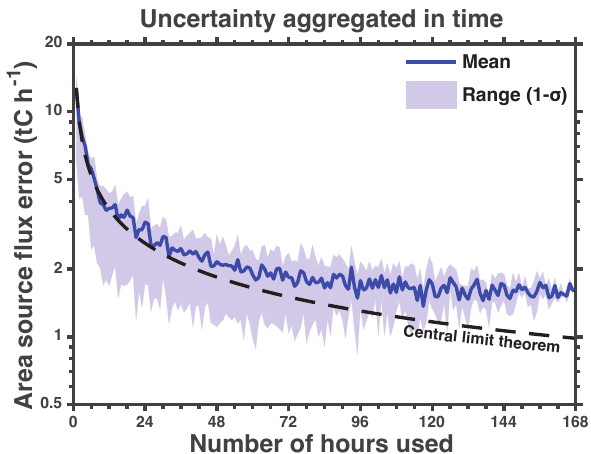
Figure 5. Uncertainty aggregated in time for the best-case inver- sion (see Fig. 3). The CO 2 flux estimate in this study has an hourly temporal resolution. The uncertainty in the emissions estimate de- clines as the estimate is averaged to longer temporal scales. Solid blue line is the mean uncertainty, shading is the 1 σ range, and the dashed black line is the uncertainty predicted by the central limit theorem. Note the log scale on the y